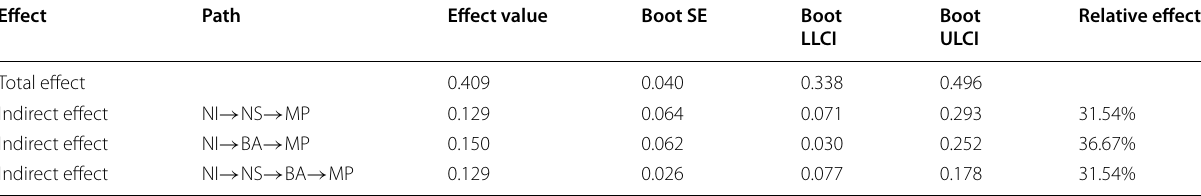
Table 3 The mediating effect of number sense and basic calculation between nonverbal intelligence and mathematical performance